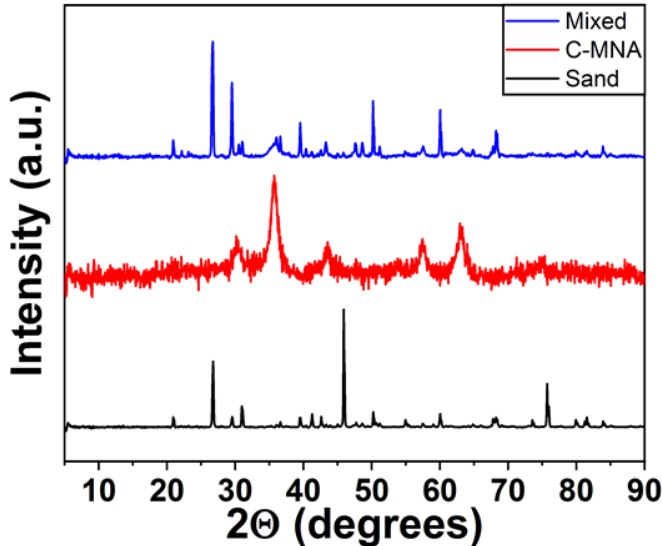
Figure 2. X-ray powder diffraction (XRD) patterns of column materials sand, C-MNA, and a mixture of the two.